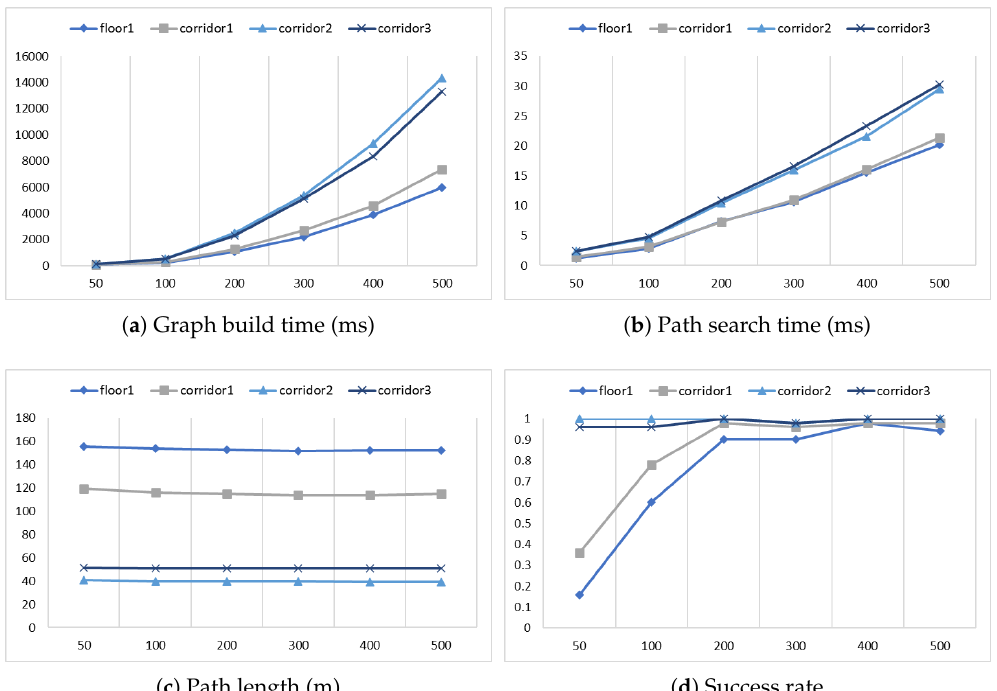
Figure 13. Influence of the number of samples (x-axis) on the PRM